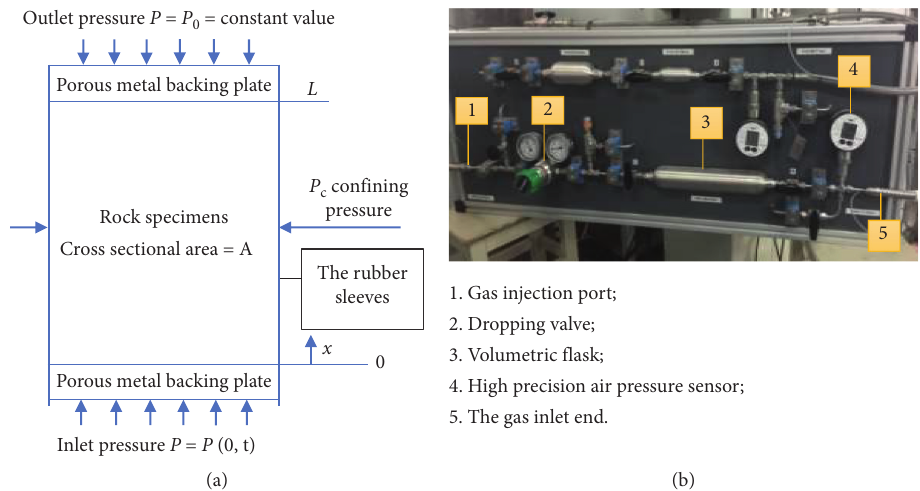
Figure 4: Principle of quasistatic method and the corresponding experimental system. (a) Principle of quasistatic method; (b) apparatus for measuring the permeability by transient method.